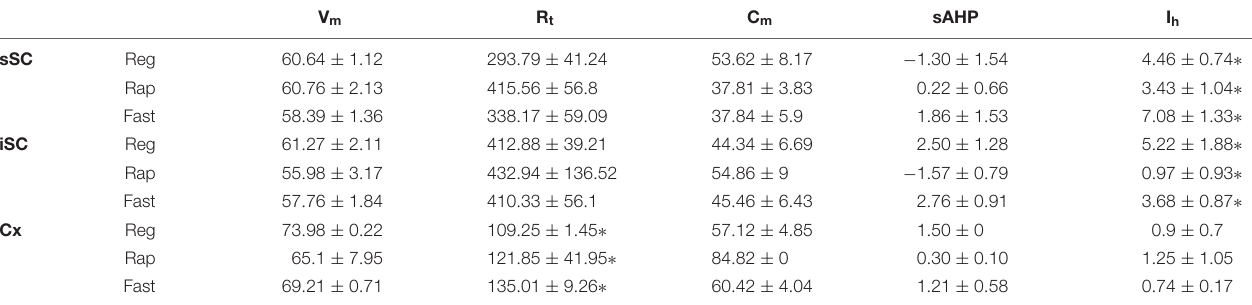
TABLE 1 | Electrophysiological parameters from PV + neurons in the SC. V m R t C m sAHP I h sSC